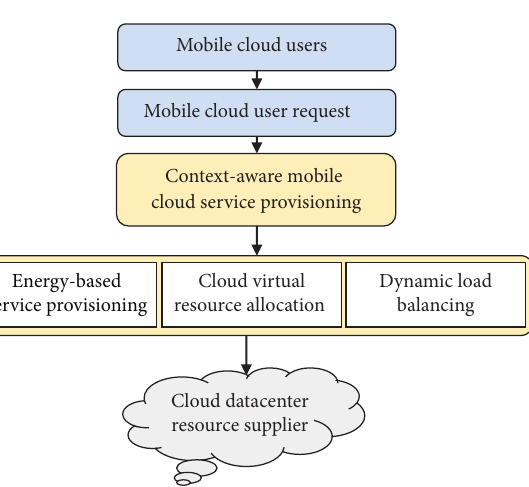
Figure 8: Overview of system model